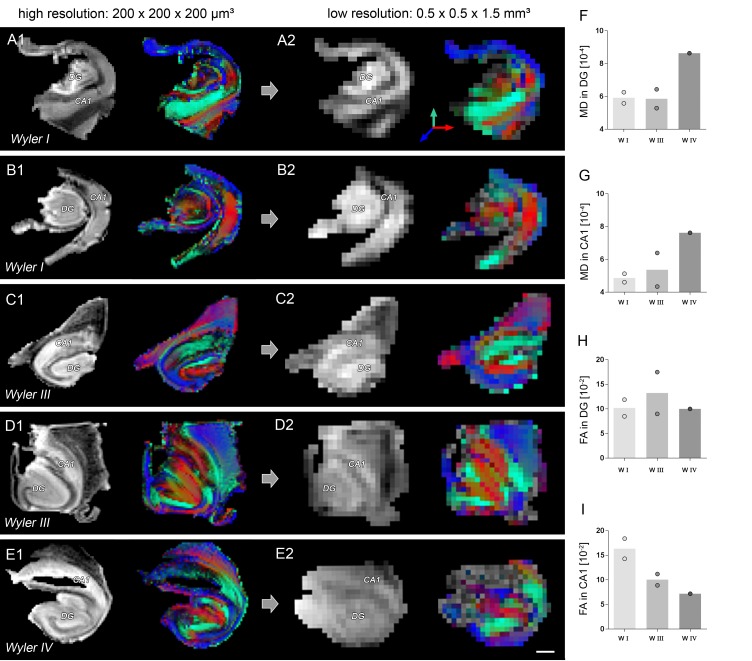
Comparison of high- and low-resolution ex vivo DWI.(A1–E1) T2-weighted images and corresponding FA maps of human hippocampi from mTLE patients scanned ex vivo at high (200 × 200×200 µm³), and (A2–E2) at low resolution (0.5 × 0.5×1.5 µm³). FA maps are color-coded for orientation: dorsoventral, turquoise; medio-lateral, red; rostro-caudal: blue. (F–G, H–I) Quantitative analysis for mean diffusivity (MD) and fractional anisotropy (FA) in CA1 and in the DG at low scanning resolution. Scale bar: 2 mm.